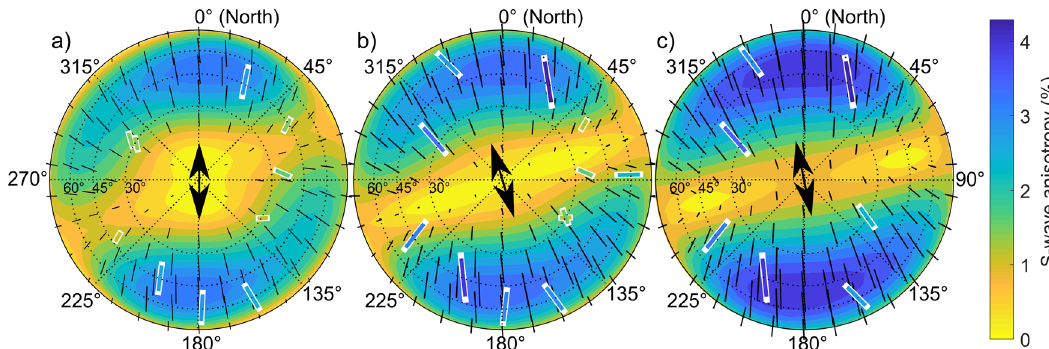
Fig. 4 Shear-wave splitting signature resulting from different ice-fabric models. a – c Upper hemisphere projections of measured SWS data (heavy coloured ticks with white outlines) and the best fi tting ice-fabric models (black ticks and background colour). The tick position indicates the azimuth and inclination (radial coordinate) of the ray path, the tick orientation indicates the fast S-wave polarization, colours and lengths of tick marks indicate the magnitude of S-wave anisotropy, and a thick black arrow indicates strike of vertical fracture set. a Inversion result of the low anisotropy scenario (SWS data within grey boxes in Fig. 3). b Inversion results for high anisotropy scenarios with all available SWS data (within all yellow boxes in Fig. 3) resulting in 0.8% of extra fractures striking at 160°. c Same as in ( b ) but using only days with elevated meltwater discharge (more than 10 m 3 s − 1 ; data within not hatched yellow boxes in Fig. 3) resulting in 1.6% of extra fractures striking at 180°. The modelled fracture growth affects primarily S-wave anisotropy magnitude while fast polarization angles change